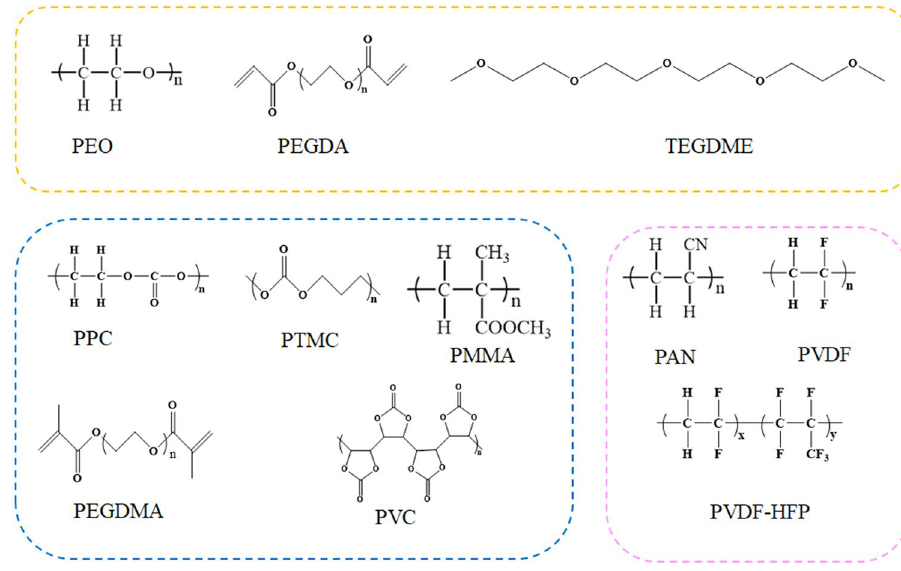
Fig. 1 Chemical structure of commonly polymers [45–64]